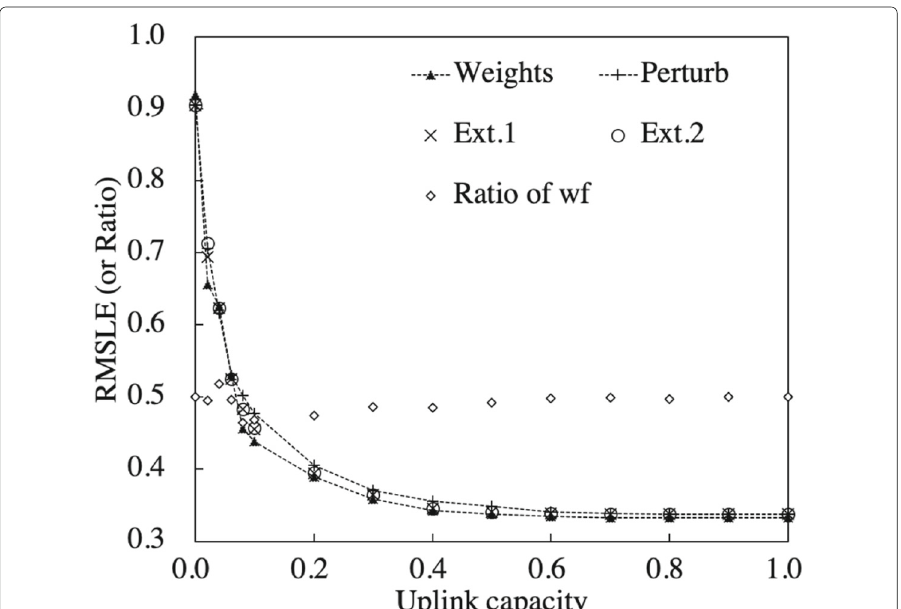
Fig. 10 Prediction accuracy (RMSLE) vs. uplink capacity obtained using LSTM for prediction. Perturb, weights, extension scheme 1 with ranking, or extension scheme 2 were used for feature selection. Ratio of w f for perturb to other in extension scheme 2 is also plotted